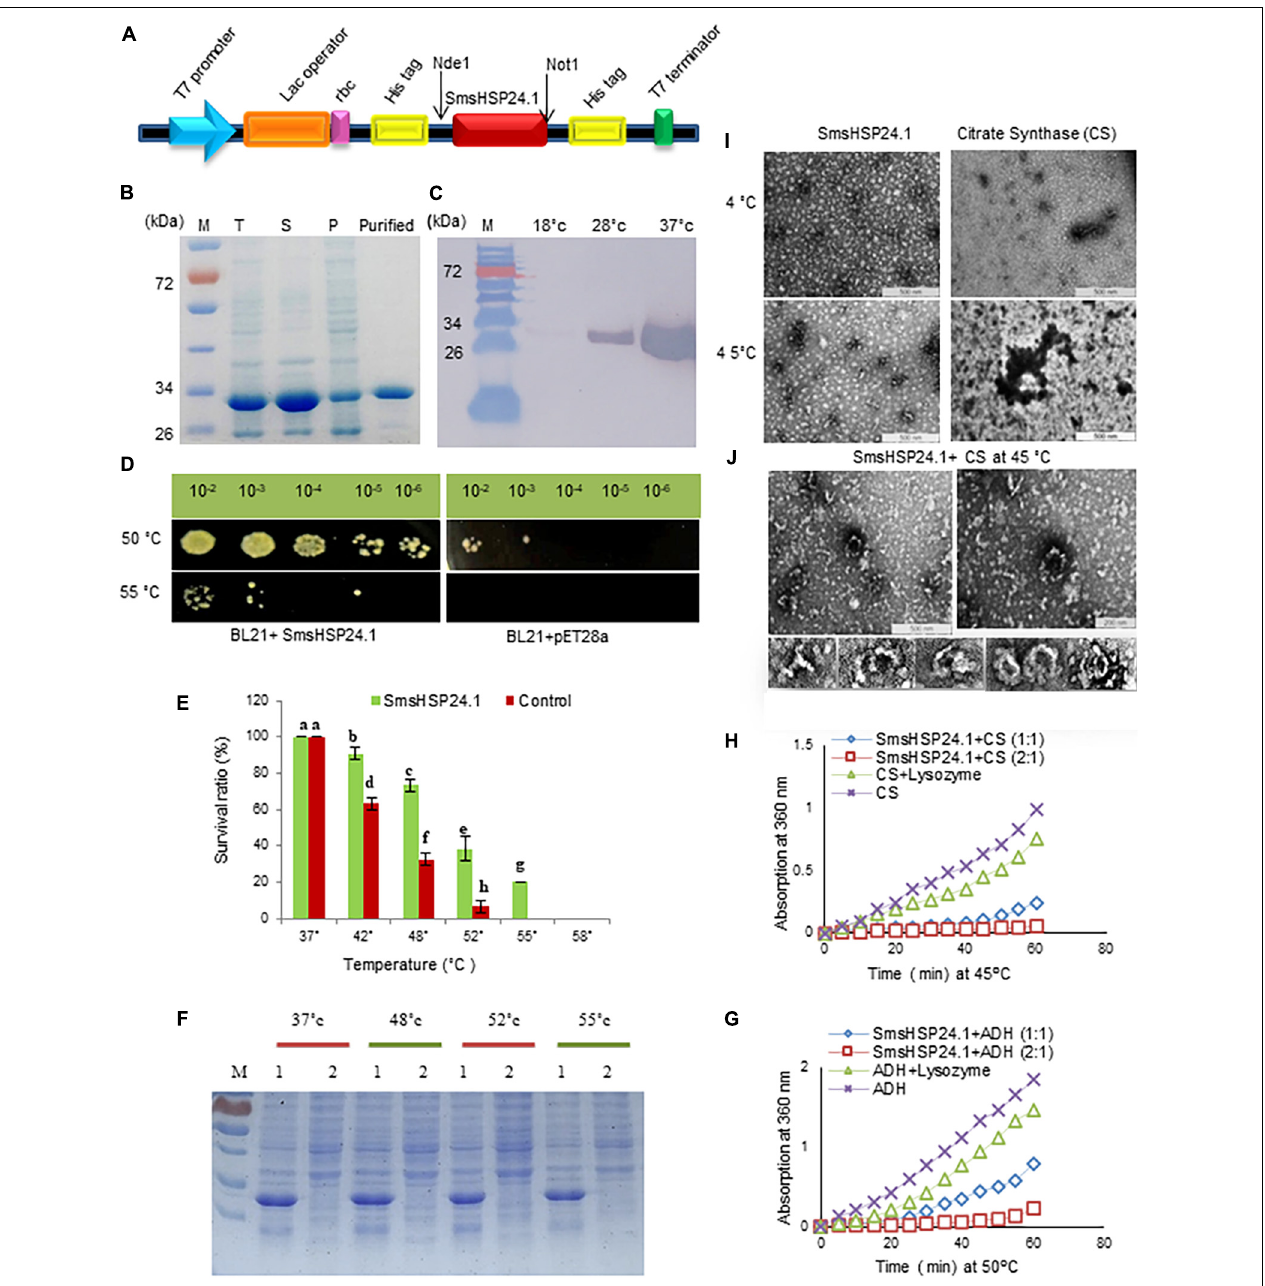
FIGURE 2 | Recombinant SmsHSP24.1 protein expression and chaperone activity assay. (A) Schematic diagram of SmsHSP24.1 protein expression cassette. (B) SDS–PAGE analysis of the proteins present in the total lysates (T), soluble (S), insoluble pellet (P), and purified SmsHSP24.1 protein. (C) Western blot of SmsHSP24.1 protein with Anti-His tag antibody. (D) pET28a:SmsHSP24.1 and control pET21a plasmid harboring BL21 cells grown in LB medium after being heat-shocked for an hour at 50 ◦ C and 55 ◦ C. (E) Colony-forming units counted from heat-treated and non-treated cells at different temperatures. (F) Proteins solubility was analyzed in SDS–PAGE at different temperature periods; 1: BL21a:SmsHSP24.1, 2: Blank BL21a. (G,H) Thermal aggregation of CS and ADH detected by light scattering at 360 nm. (I) Transmission electron microscopy images of SmsHSP24.1 and citrate synthase (CS) protein at 4 ◦ C and 45 ◦ C, respectively, Scale bars represent 500 nm. (J) Electron microscopy images clearly show SmsHSP24.1 protein prevents model substrate CS when incubated at 45 ◦ C for 60 min. Scale bars represent 500 nm (Left panel) and 200 nm (Right panel), SmsHSP24.1protein forming different polyhedron assemblies (Lower panel).